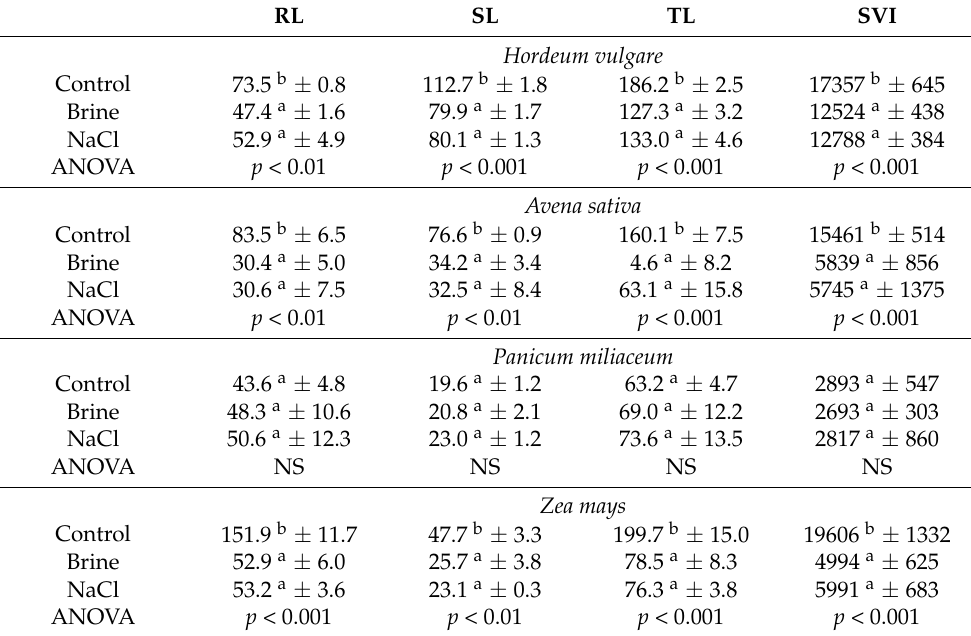
Table 1. Osmotic and ionic composition effects on seedlings of model plants after seven days of growth. Average values ( X ) with standard error (SE) are given ( X ±